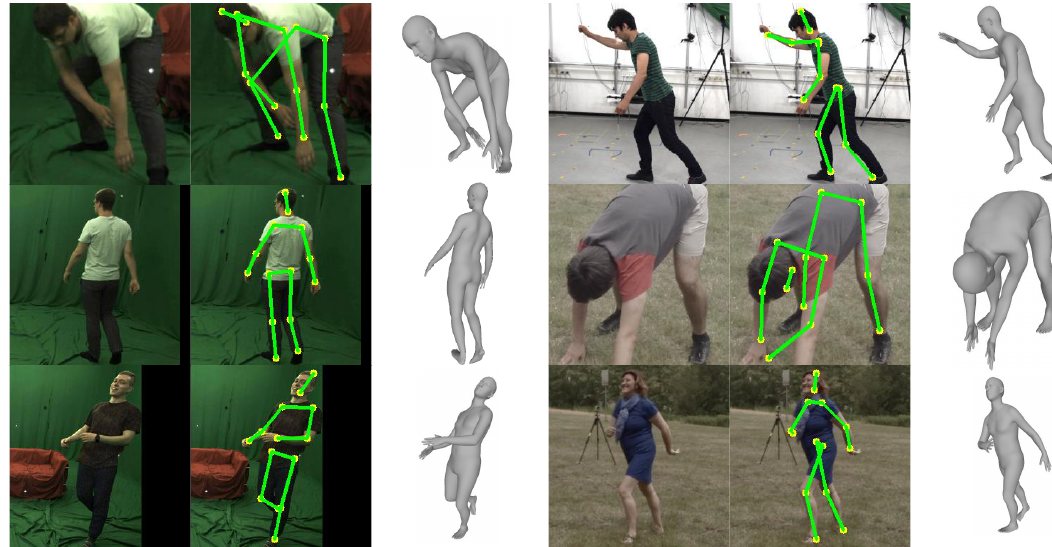
Figure 8. Qualitative results on the MPI-INF-3DHP dataset.